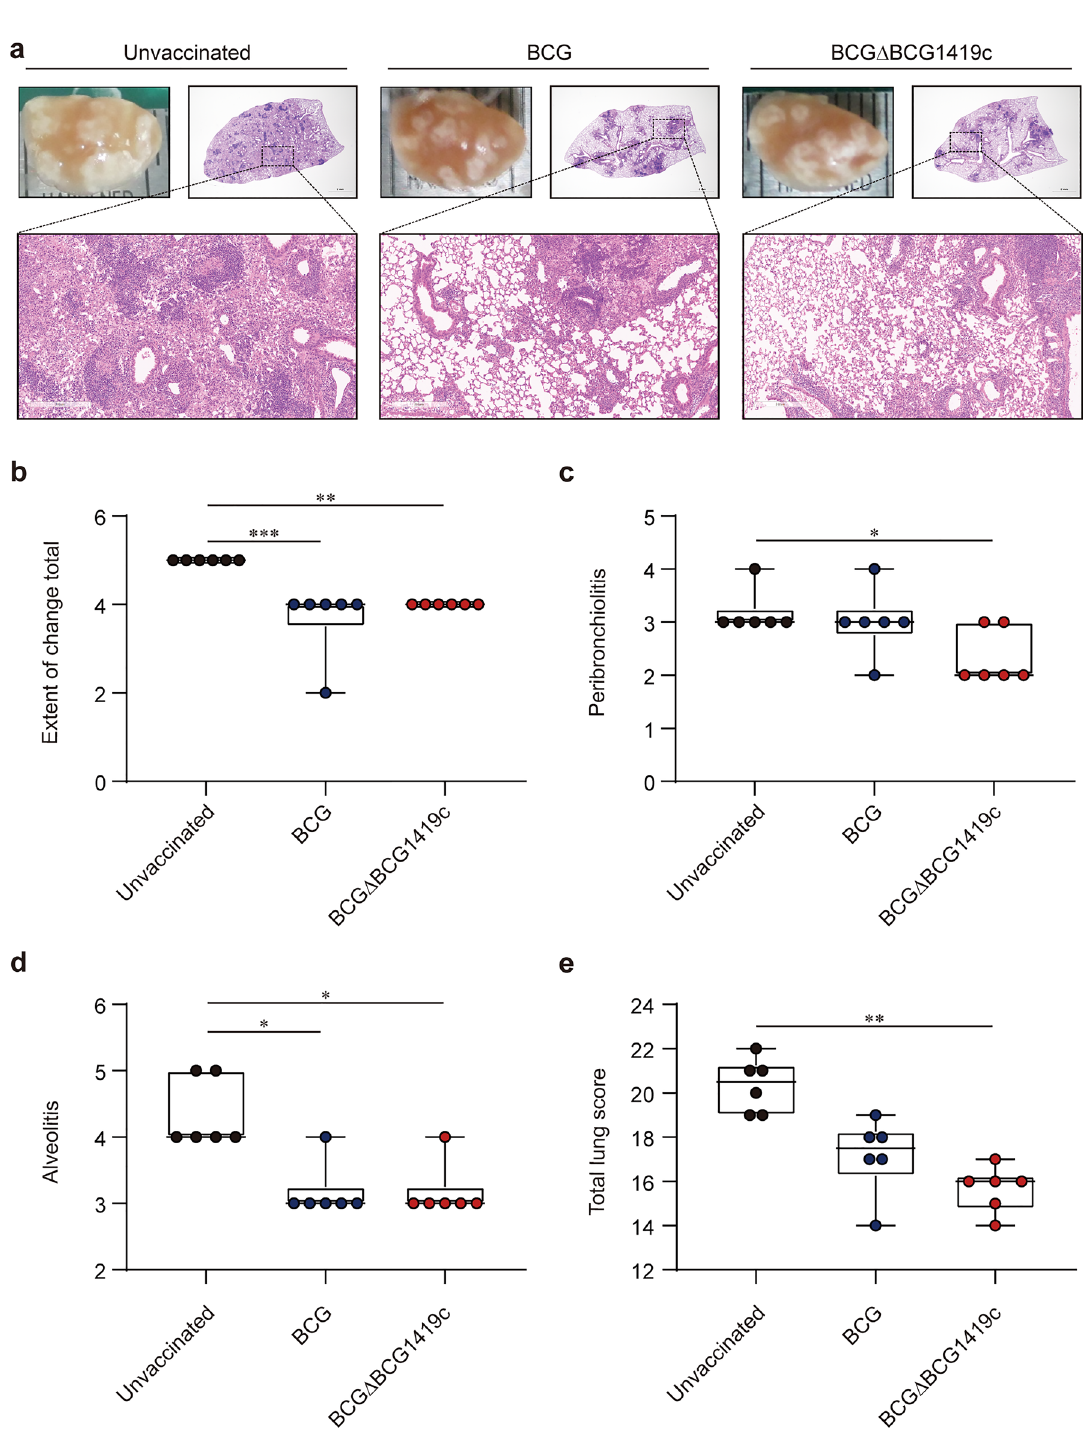
Figure 4. Histopathological assessment of pulmonary inflammation in BCG- and BCGΔBCG1419c-vaccinated mice upon Mtb strain M2 infection. ( a ) The superior lobes of the right lung of each subset of mice ( n = 6/ group) were analysed by H&E staining, and representative lung lobes are displayed as gross images at 10 weeks post-infection (10×: scale bar = 2.0 mm, 100 × : scale bar = 300 μm). ( b–e ) Then, H&E-stained sections were scored for the extent of total change, peribronchiolitis, alveolitis, and total lung score were assessed with the scoring system described in Methods. Data ( n = 6) from one representative experiment are presented as a box and whisker plot showing all points. Kruskal–Wallis followed by Dunn’s multiple comparison test was used to evaluate the significance. * p < 0.05, ** p < 0.01, and *** p <